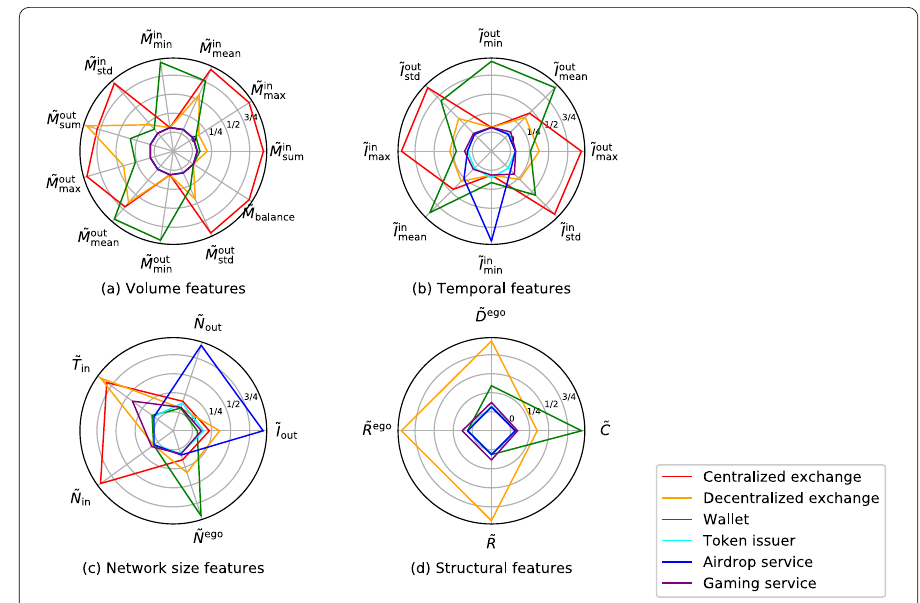
Figure 2 Distribution of the six key cryptocurrency economic agents in four groups of transaction features. Each of the data points is a min-max normalized logged median (marked with a ˜· ) feature value for each type of economic agents. Some types of agents have obvious distinct feature values. Plots of feature distributions with their absolute values can be found in Additional file 1 Sect.